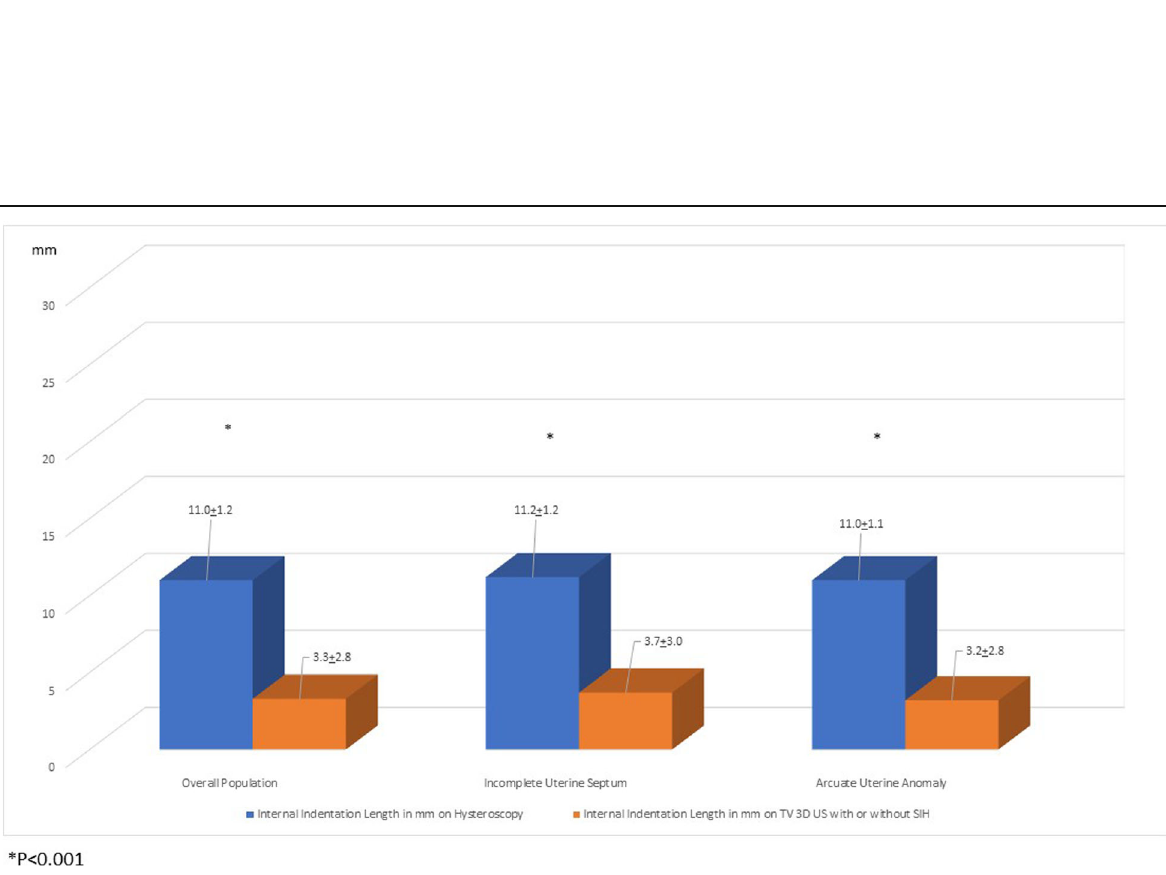
Fig. 5 Comparison between the mean IILFM measured in mm on hysteroscopy and on TV 3D US with or without SIH, in patients with IUS, significant AUA, and in the overall population in patients with moderate internal indentation length (10 – 14